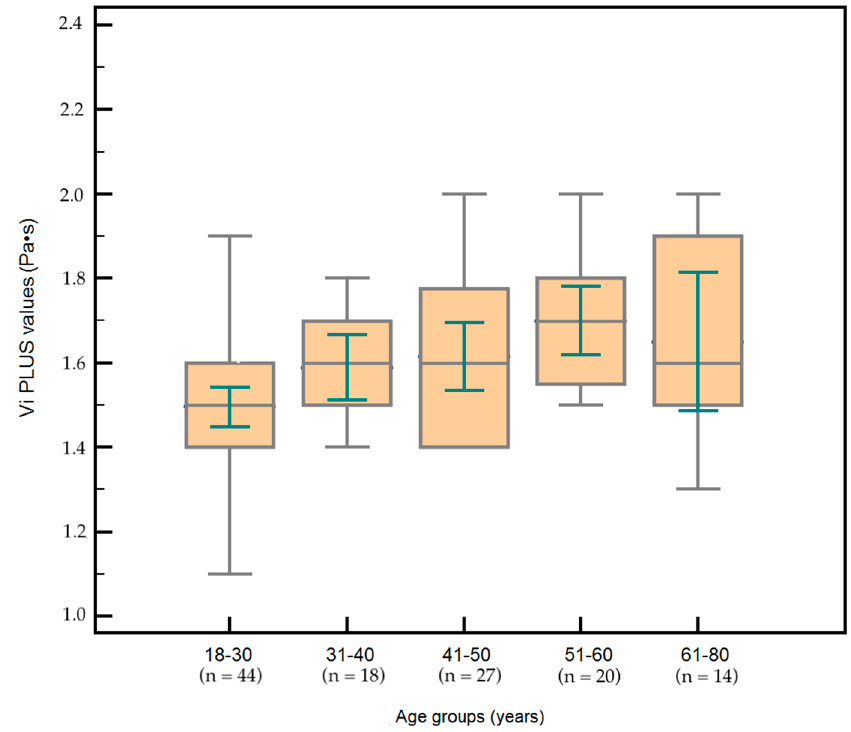
Figure 4. Box-and-whisker distribution plots comparing Vi PLUS values according to five different age subgroups. VI PLUS values slightly increased with each decade of age.